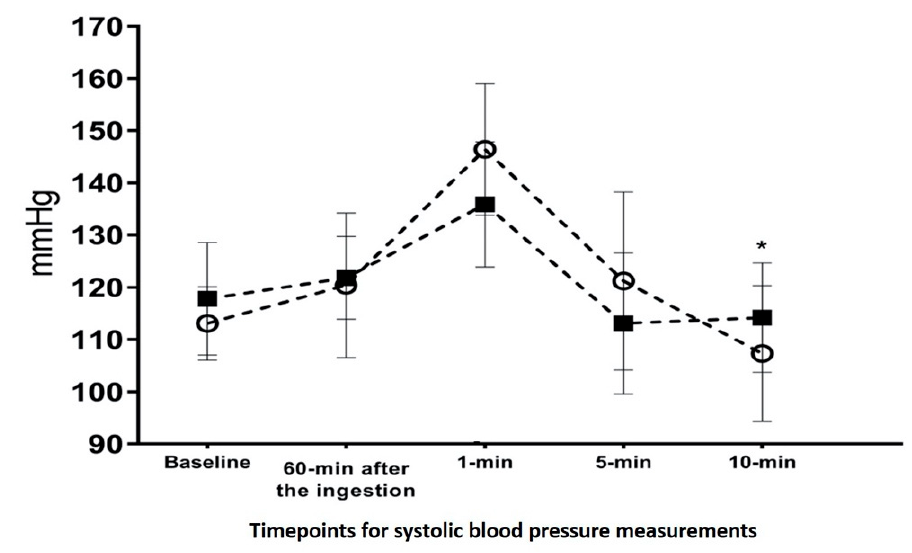
Figure 3. The changes of systolic blood pressure. The square indicates the placebo trial while the circle indicates the energy drink trial.* p < 0.05, indicates a significant change from recovery 5-min to 10 min only in the energy drink trial. mmHg: millimeters of mercury, SBP: systolic blood pres- sure.